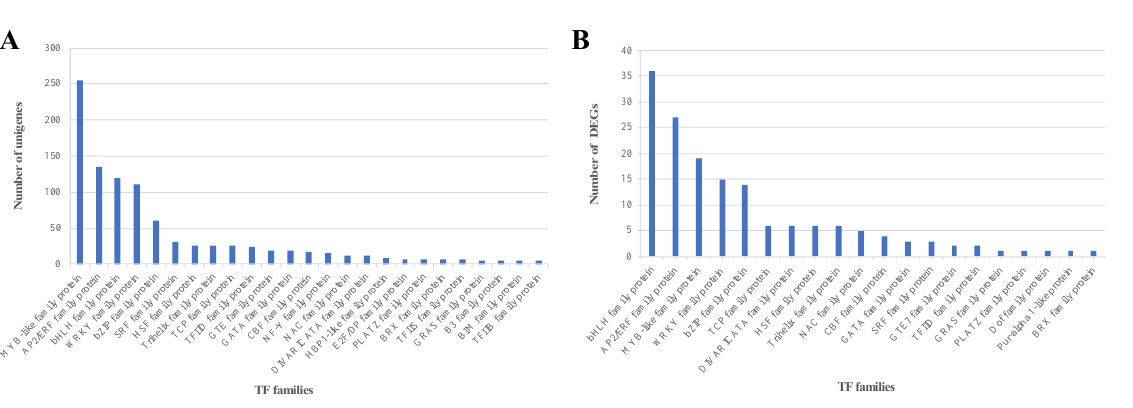
Figure 1. ( A ) Distribution of transcription factors (TFs) in C. grandiflora ’s transcriptome. ( B ) Distribution of transcription factors (TFs) differentially expressed in salt-treated and control plants of C. grandiflora .